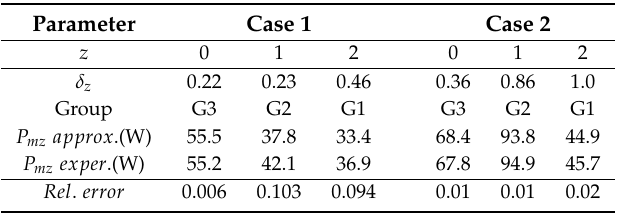
Table 9. Maximum power